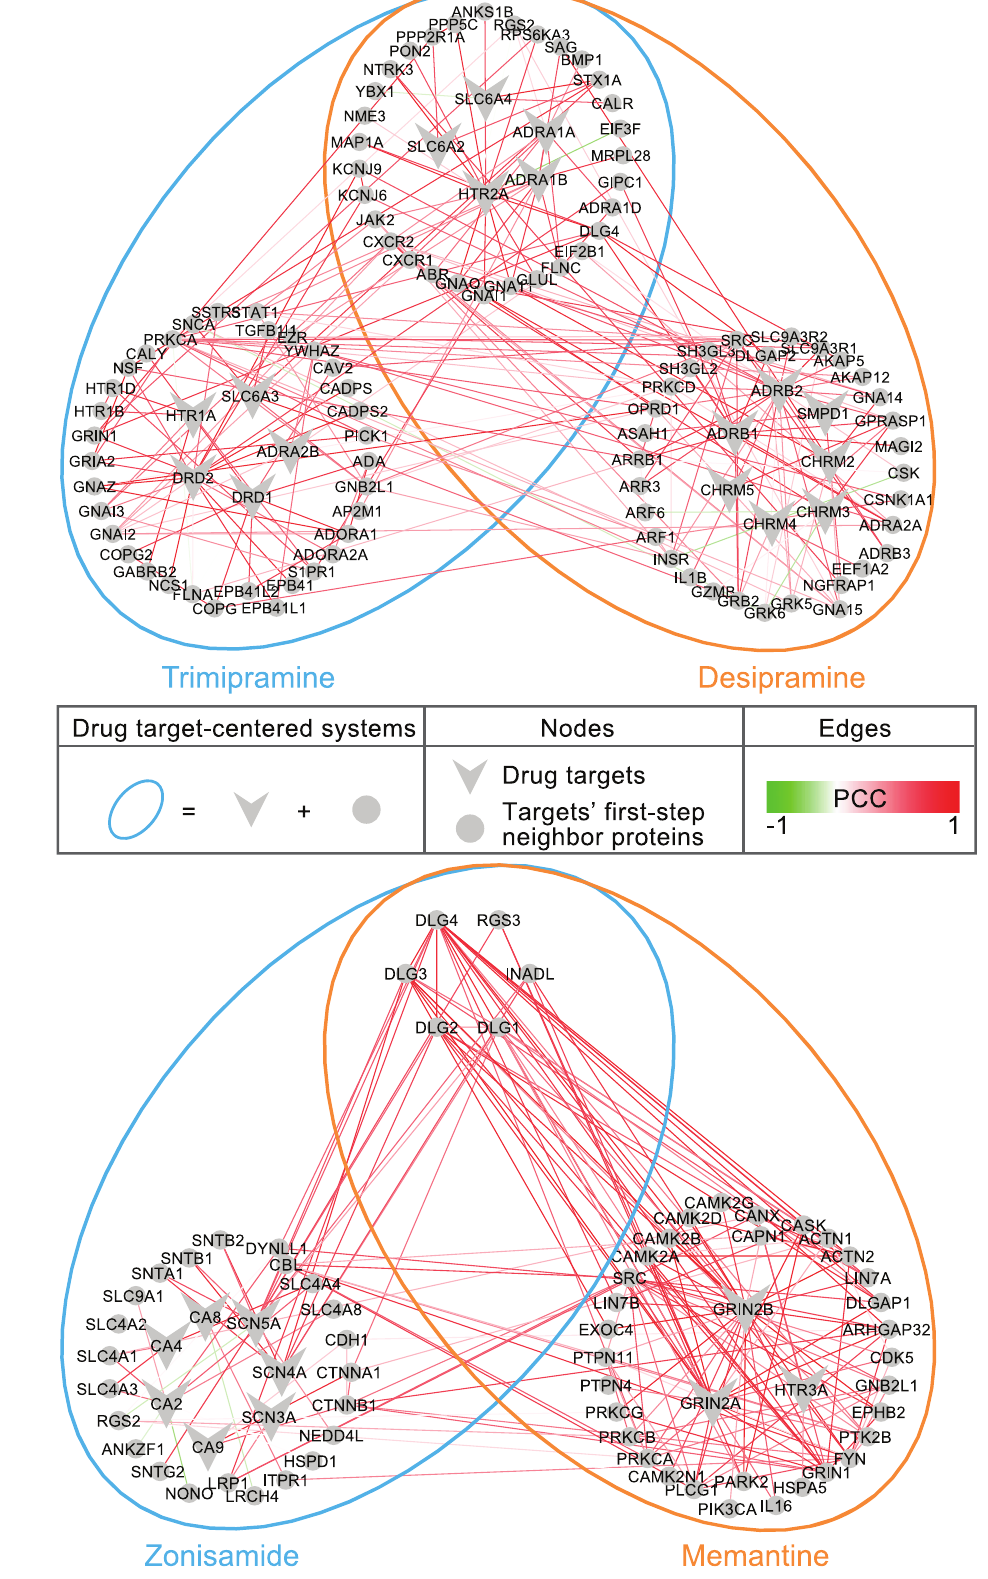
Figure 4. Case studies. ( A ) Desipramine and trimipramine. ( B ) Zonisamide and memantine. The drug target-centered systems (ellipse) colored for different drugs, includes drug targets (vee) and their first-step neighboring proteins (circle) in the PPI network. The edges in the network were weighted by the PCC based on cross-tissue expressions. doi:10.1371/journal.pcbi.1002998.g004 PLOS Computational Biology | www.ploscompbiol.org March 2013 | Volume 9 | Issue 3 |